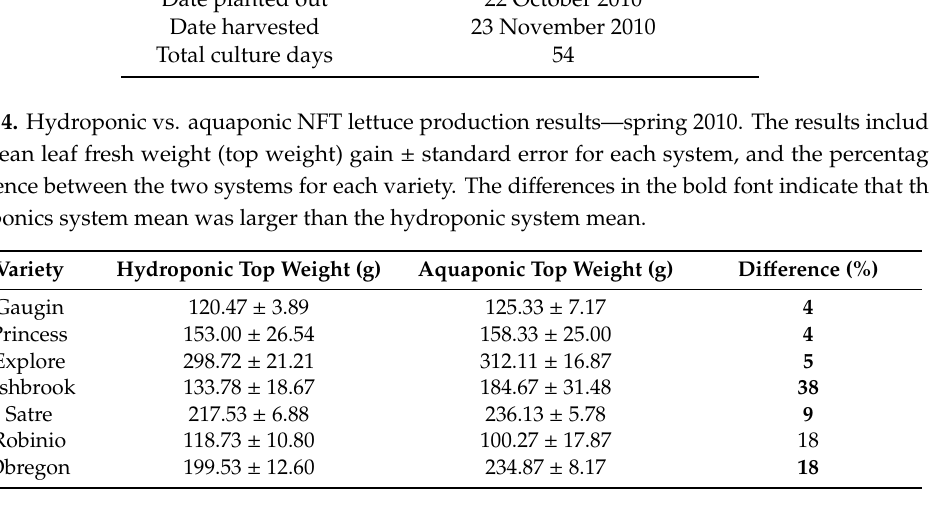
Table 5. Growth period parameters for hydroponic vs. aquaponic NFT lettuce production—winter 2010.